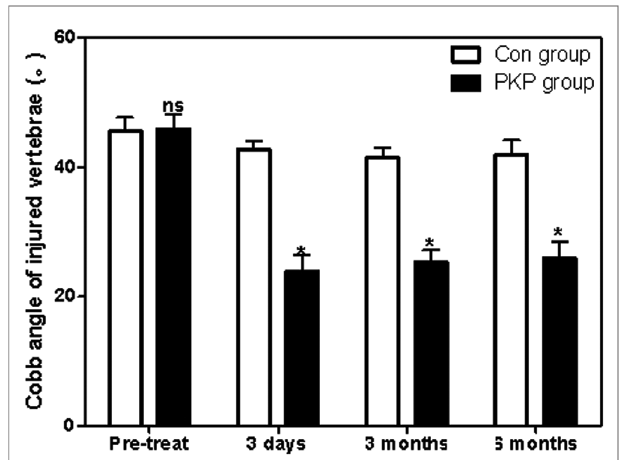
FIGURE 3 | Comparison of the Cobb angle of injured vertebrae at different times between two groups. Note: Compared with the Con group, ns P >0.05 and * P